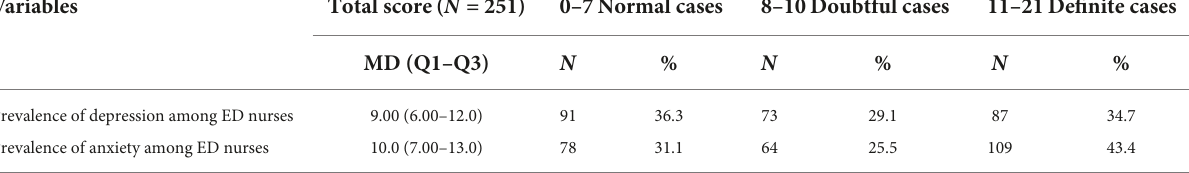
TABLE 2 Descriptive anxiety and depression statistics among ED nurses ( N = 251).